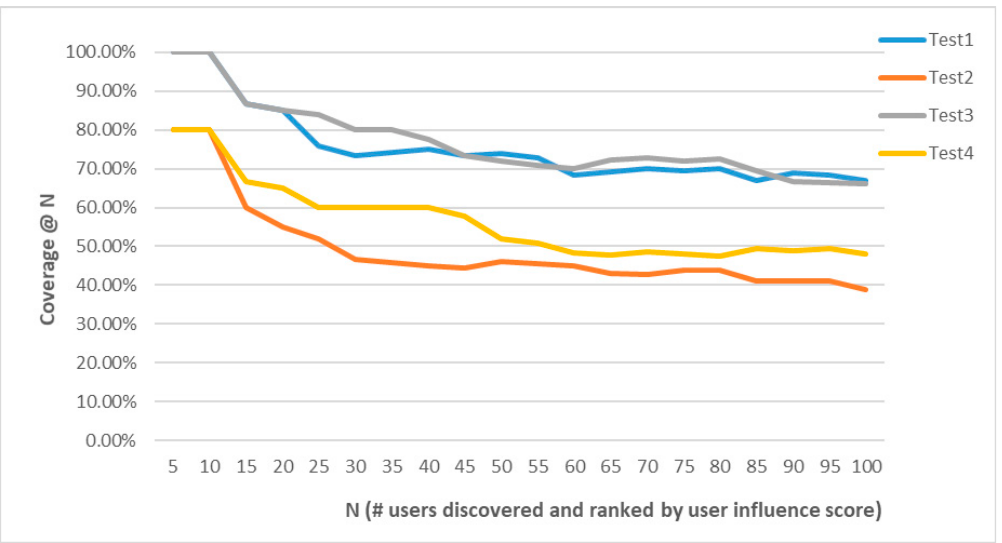
Figure 6. The coverage rates for different sets of edge weighting.